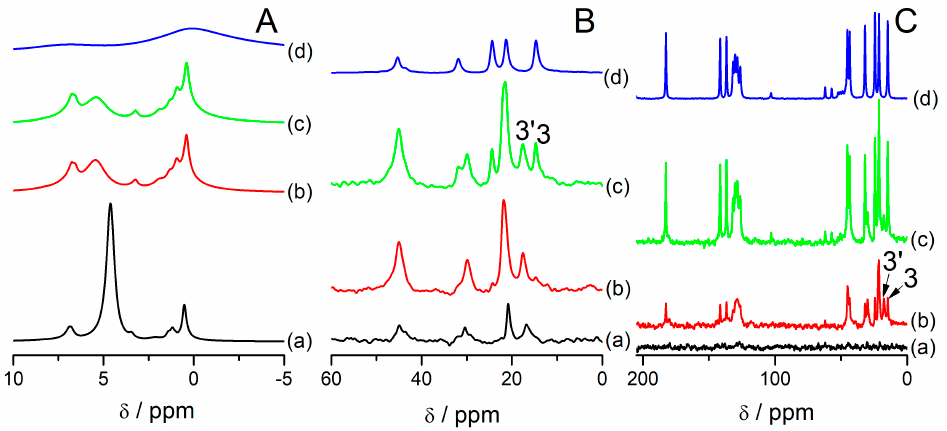
Figure 4. 1 H MAS NMR ( A ), 13 C HPDEC MAS NMR ( B ), and 13 C CP MAS NMR ( C ) spectra of the samples: FAU31–12IBU ( a ), FAU31–24IBU ( b ), FAU31–38IBU ( c ), and crystalline ibuprofen ( d )